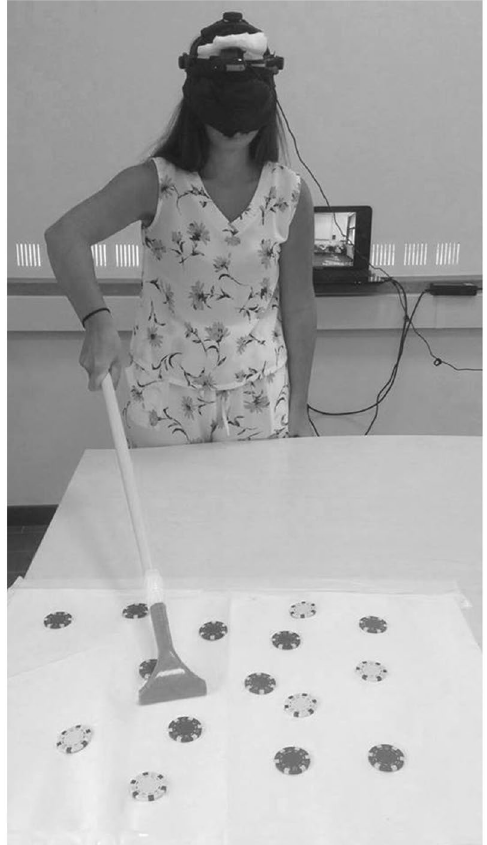
Figure 4. Experimental setup of tool-use. A webcam was applied on the HMDs worn by the participants. Participants were instructed to reach and retrieve different tokens.